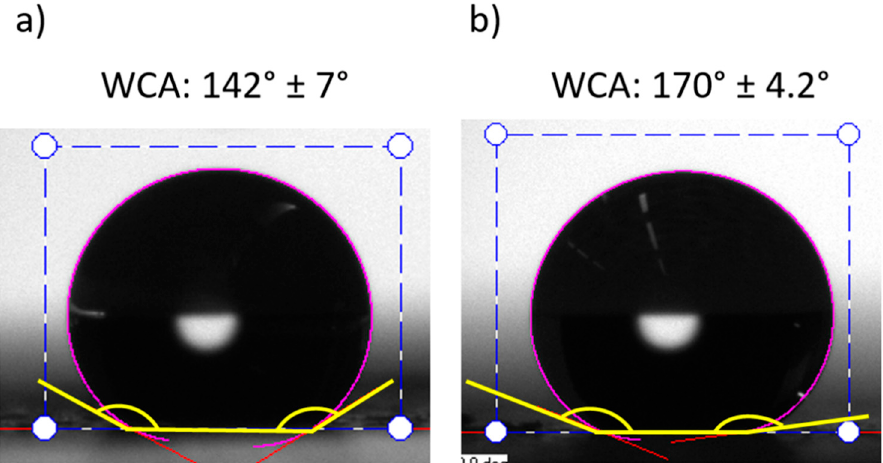
Figure 7. Static water contact angles (WCA) of samples S3 ( a ) and S4 ( b ). The sample S3 ( a ) exhibits a hydrophobic behavior (90° < WCA < 150°) and sample S4 ( b ) a superhydrophobic behavior (WCA > 150°). Table 5. The roll-off water angles ( α roll − off ), the advancing contact angle ( θ adv ), the receding contact angle ( θ rec ), and the contact angle of hysteresis (CAH) of the S3 and S4 samples.